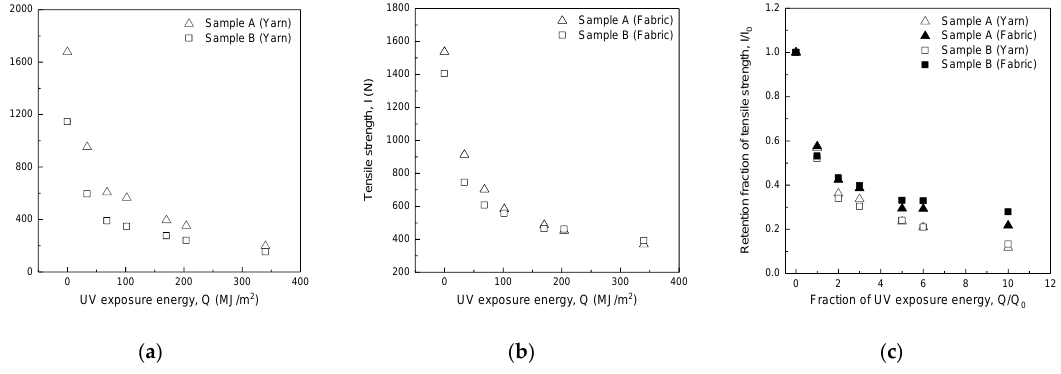
Figure 4. Change in tensile strength of yarns ( a ) and fabrics ( b ) [9] of two different yarn diameters (100% m-Aramid) and retention fraction of tensile strength ( c ) [9]. Table 4. Effect of yarn size on tensile strength and retention fraction of tensile strength (Samples A and B).